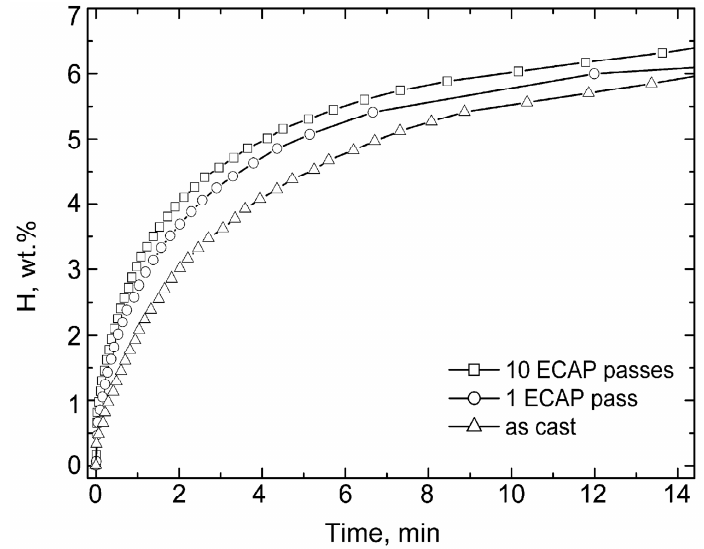
Figure 4. Kinetics of hydrogen desorption at 573 K in as-cast and ECAP-processed samples Reproduced with permission from [19], Elsevier, 2007.